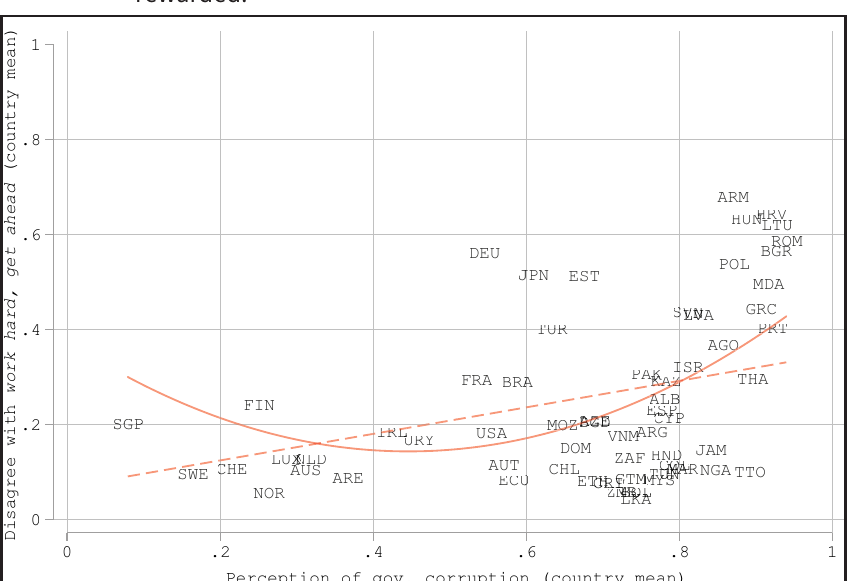
Relationship between corruption perception and notion that hard work is